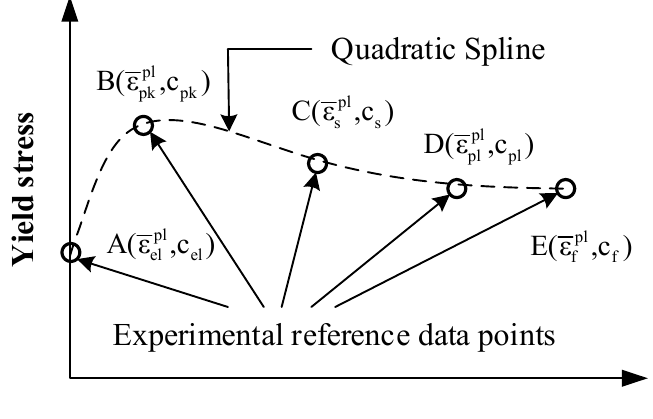
Figure 10. Illustrative hardening and softening model based on the implementation of the ABAQUS Mohr–Coulomb model.